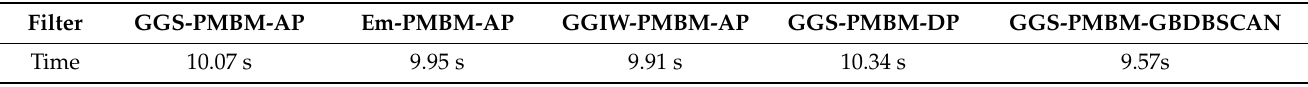
Table 5. The initial states of